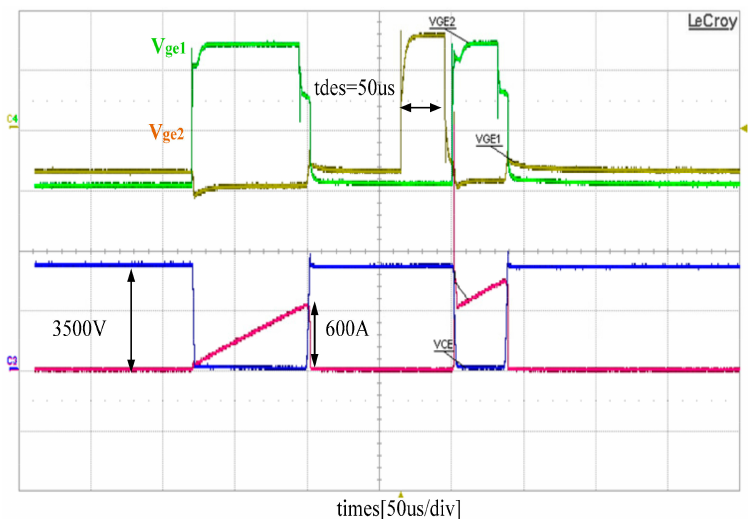
Figure 10. Waveforms of the improved dual-pulse test for the RC-IGBT with a desaturation pulse.